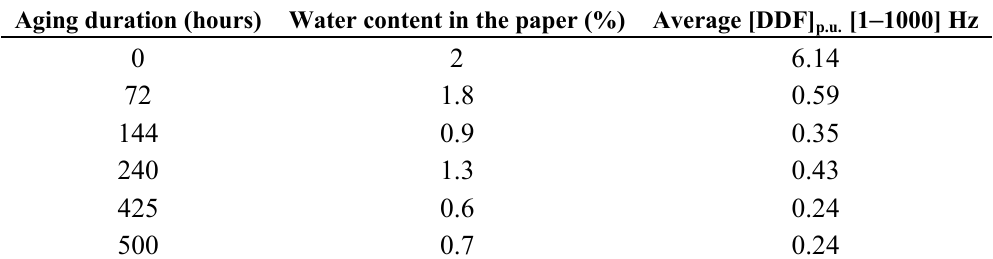
Table 1. Moisture content in paper at the end of aging